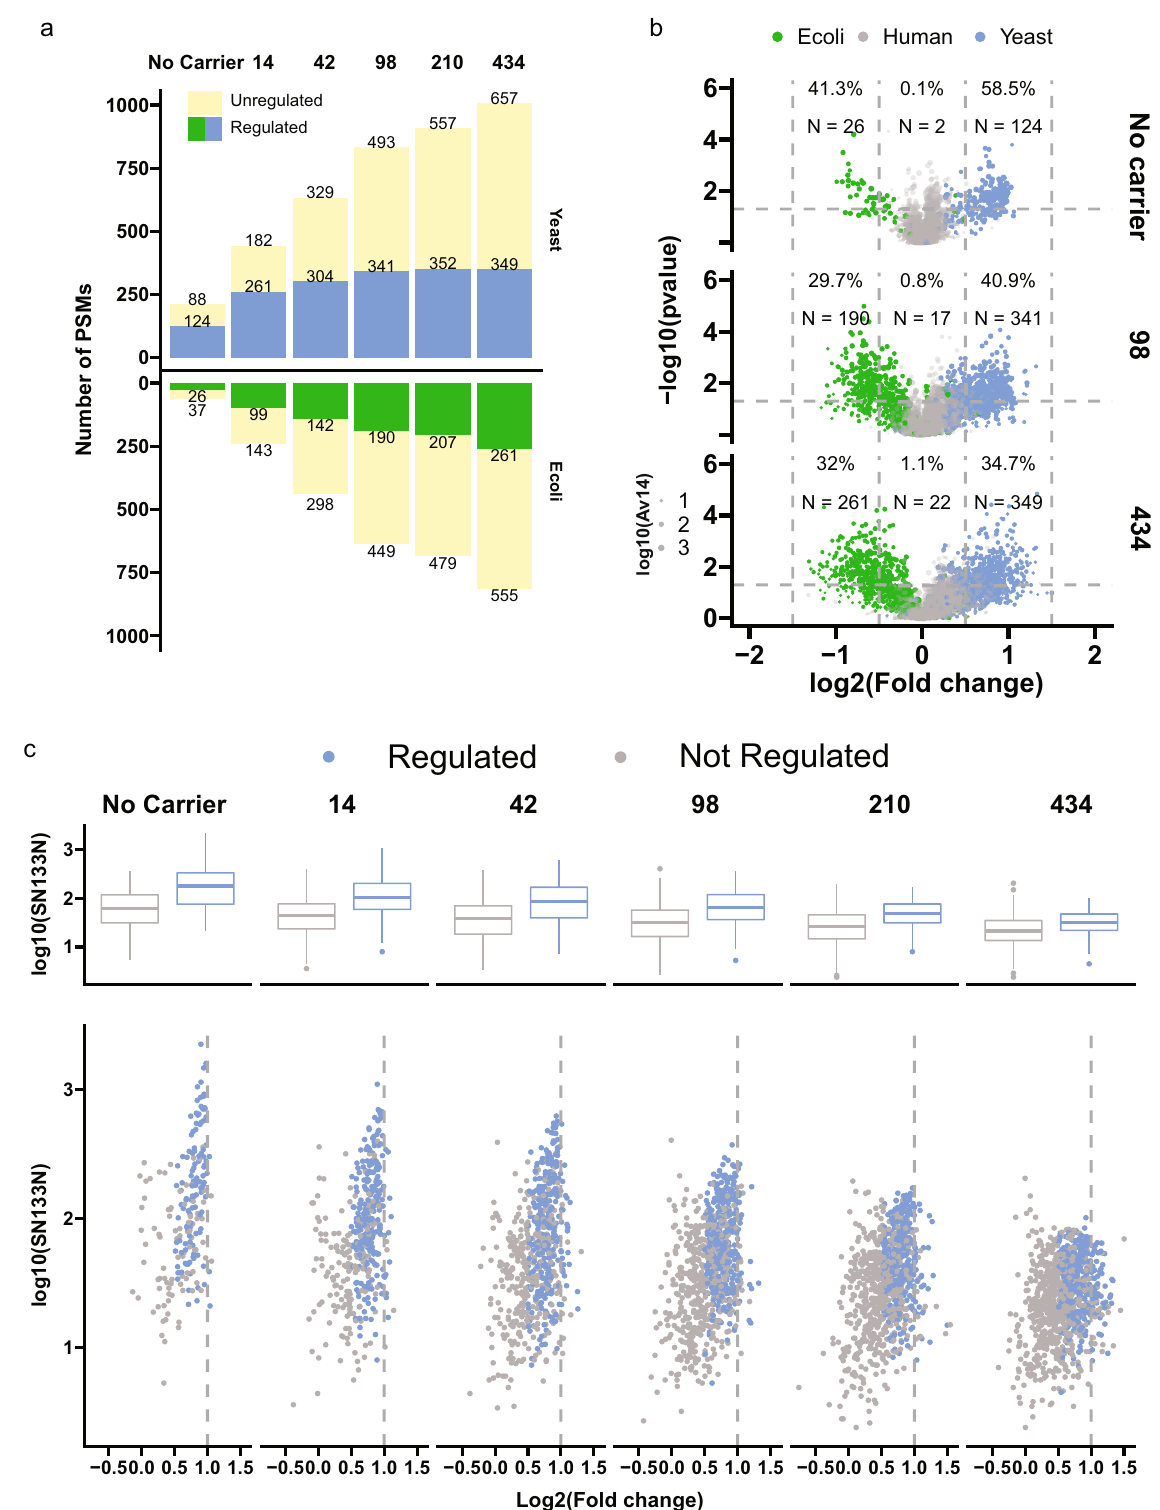
Fig. 2 Impact of the carrier proteome for detecting signi fi cantly regulated proteins. a Numbers of PSMs accurately quanti fi ed with selected TMT channels. From the 14 SCCs, we calculated log 2 ratios including, 131C/132N, 131 C/132N, 131 C/132N, and 131C/132N for yeast and human PSMs, 128N/ 128C, 129N/130C, 129C/131C, and 130 N/132C for E.coli PSMs. PSMs with Parent intensity fraction ≥ 0.98 and Av14 ≥ 1 were kept. Samples with the following settings were selected: carrier proteome not as H; AGC300%. b Volcano plots of number of PSMs accurately quanti fi ed with selected TMT channels. N number of PSMs. The dash lines indicate cutoffs in fold change and p-values. c Abundance distribution (upper panel: boxplot; lower panel: scatter plot) of regulated and non-regulated yeast peptides. The Y -axis displays SN values of channel 133 N which represents the highest abundance of yeast peptides. In both b and c calculations of numbers were the same as a . PSMs with log2-fold change higher than 0.5 at p < 0.05 were designated as